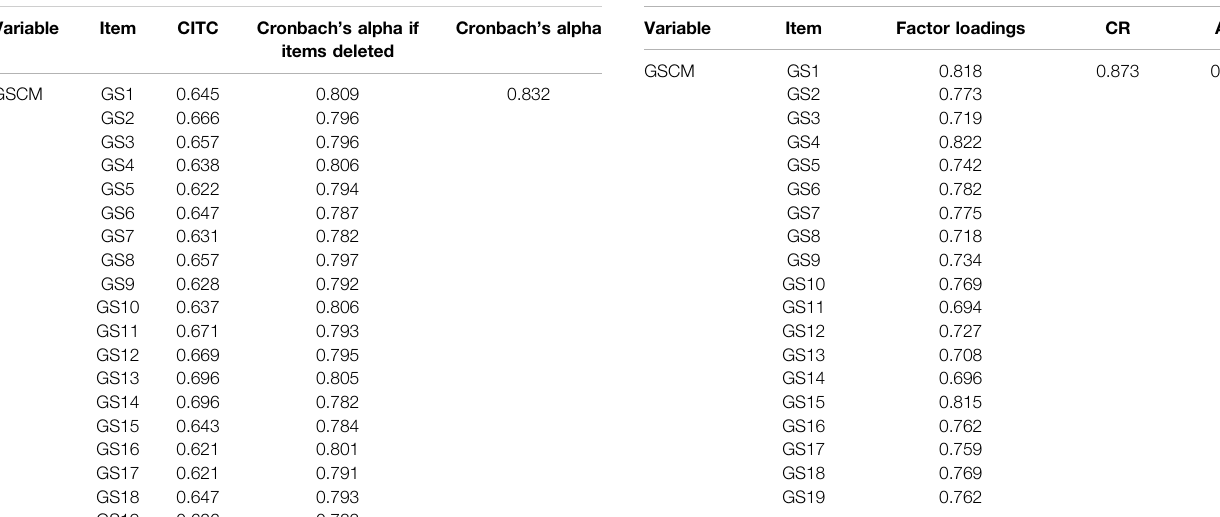
TABLE 2 | Reliability analysis results. TABLE 3 | Validity analysis results (N =